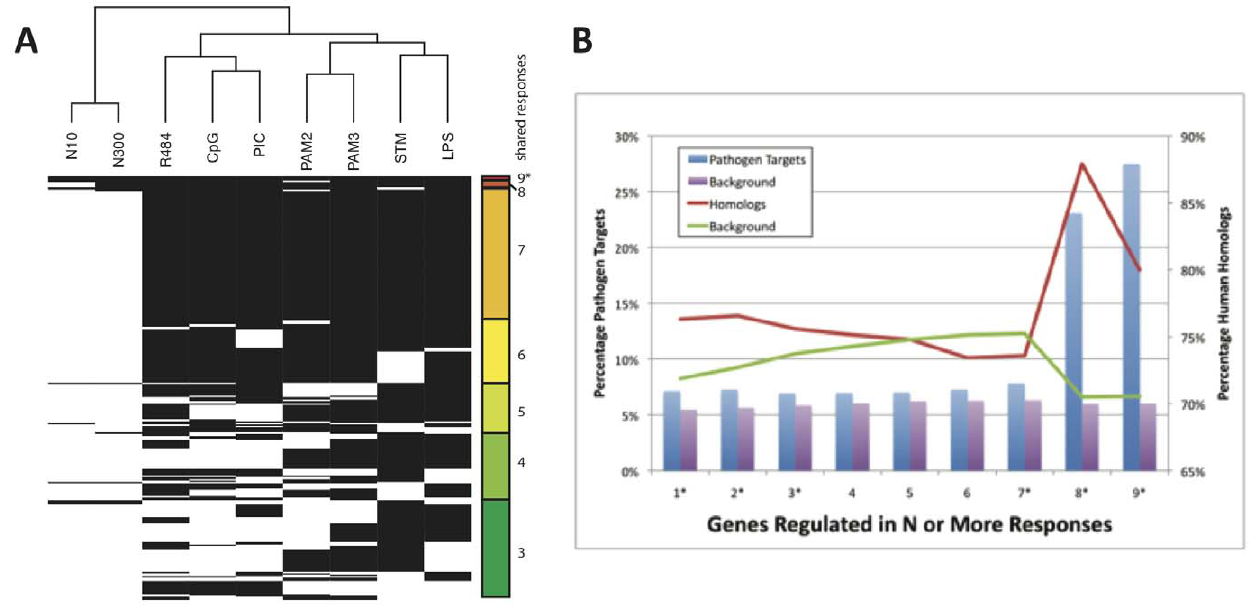
Figure 3. Response set analysis in macrophages. A. Genes (rows) with shared differential expression in response to multiple stimuli (columns) are shown with black boxes indicating differential expression. The plot is ordered from genes differentially regulated in all conditions examined (9*, the core response module), to those differentially regulated in three conditions (bottom). A dendrogram showing the similarity between stimuli is shown at top; N10, 10 nm nanoparticle; N300, 300 nm nanoparticle; STM, Salmonella infection. B. The percentage of pathogen targets (bars) in each group of genes (blue bars) or in background (not in the group; purple bars) is shown for each group of genes regulated by N or more stimuli (X axis). The corresponding analysis is shown for Human homologs (lines) for the group (red line) or background (green line) in each group. Asterisks by each group on the X axis indicates that these groups are statistically enriched in both homologs and pathogen targets, other values were statistically significant after multiple hypothesis correction. These results show that groups of genes that are differentially regulated in response to a broad range of stimuli are more likely to be targets of pathogens and are more conserved than other genes. doi:10.1371/journal.pone.0014673.g003 PLoS ONE |